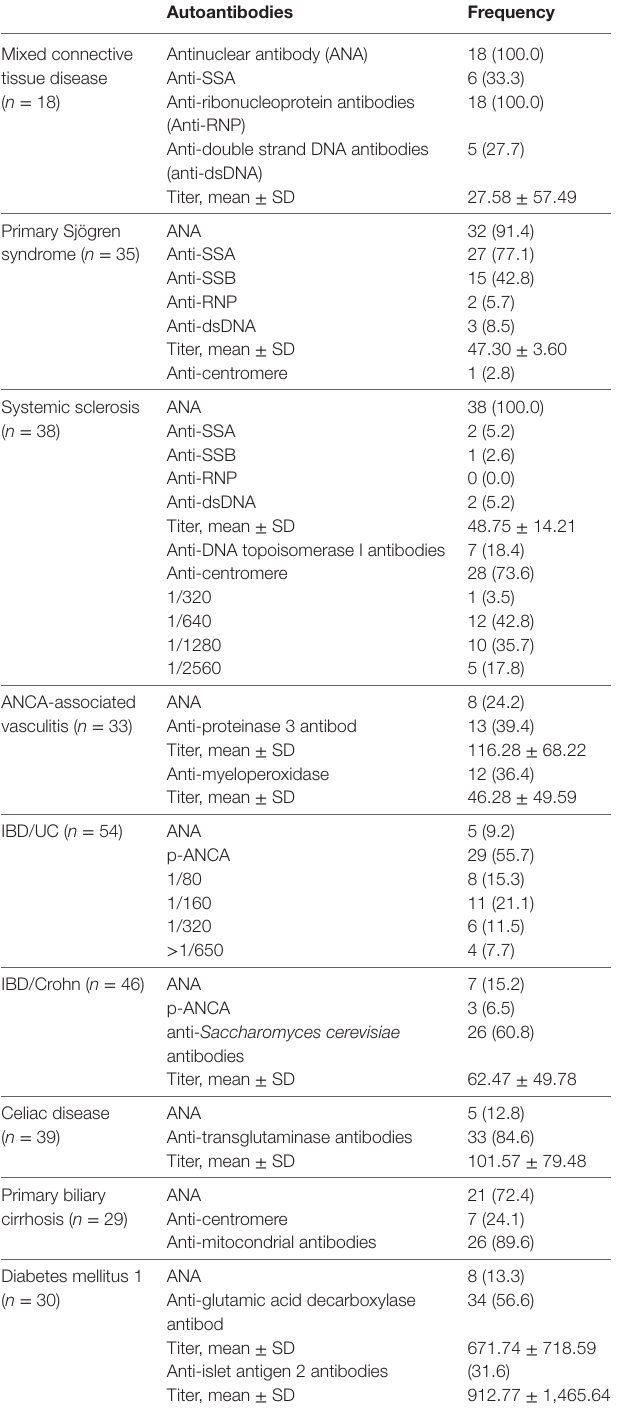
Table 3 | Disease-related autoantibodies in the individuals entered in this study.